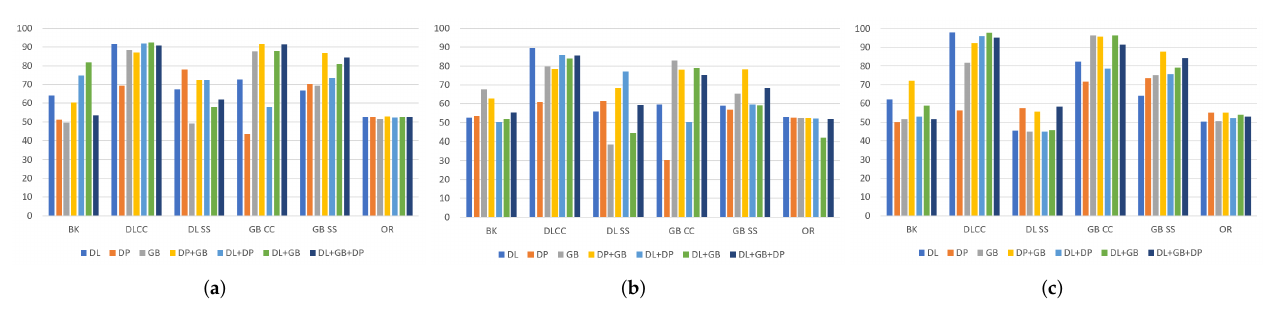
Figure 3. Comparison of self-trained protocol accuracies for ( a ) BSIF, ( b ) LBP, and ( c ) SpoofBuster with different single-sensor and multi-sensor training